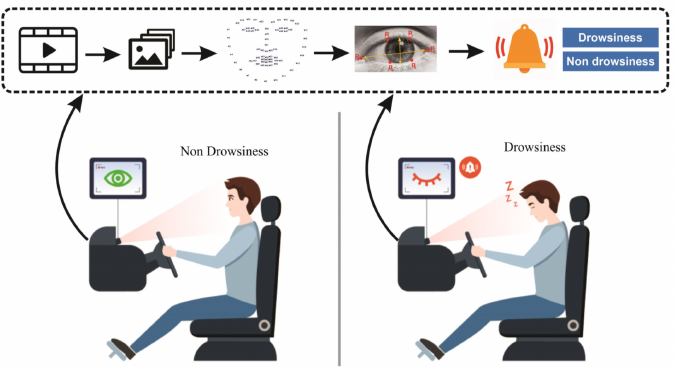
Figure 1. General model of the drowsy detection